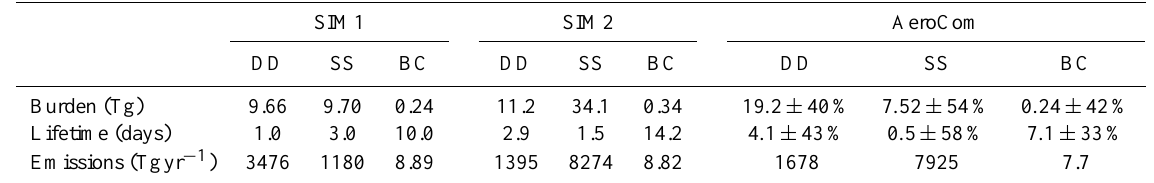
Table 4. Globally averaged annual burden, lifetime and emissions in SIM1 and SIM2 for individual aerosols species (DD – desert dust, SS – sea salt, BC – black carbon), compared to data from the AeroCom project (Dentener et al., 2006; Textor et al., 2006). For a description of model simulations, see Table 2.